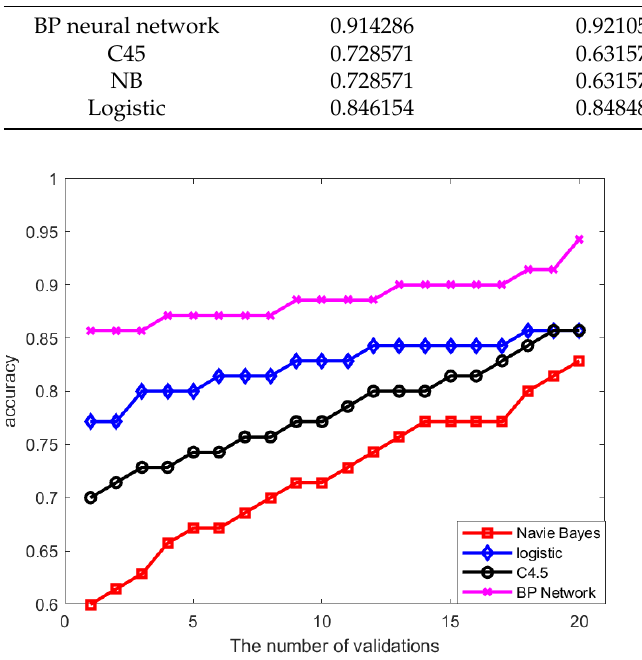
Figure 14. Average prediction accuracy of each